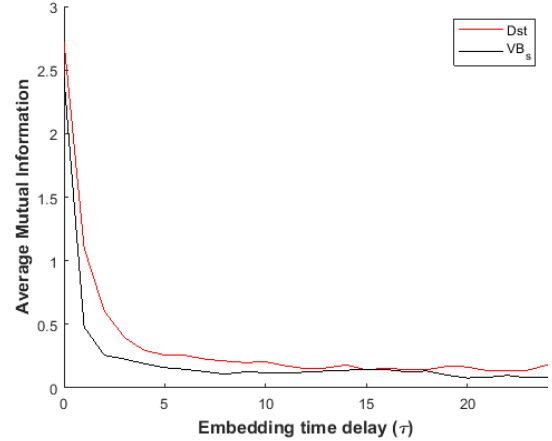
Figure 3. The plot average mutual information against embedding time delay ( τ ).